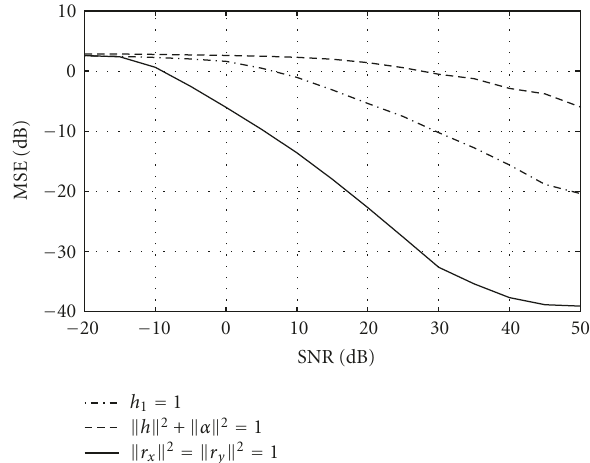
Figure 5: MSE (cid:2) e r (cid:2) 2 on the Wiener system’s internal signal. The al- gorithms based on filter coe ffi cient constraints (dotted and dashed lines) perform worse than the proposed KCCA algorithm (solid line), which is based on a signal power